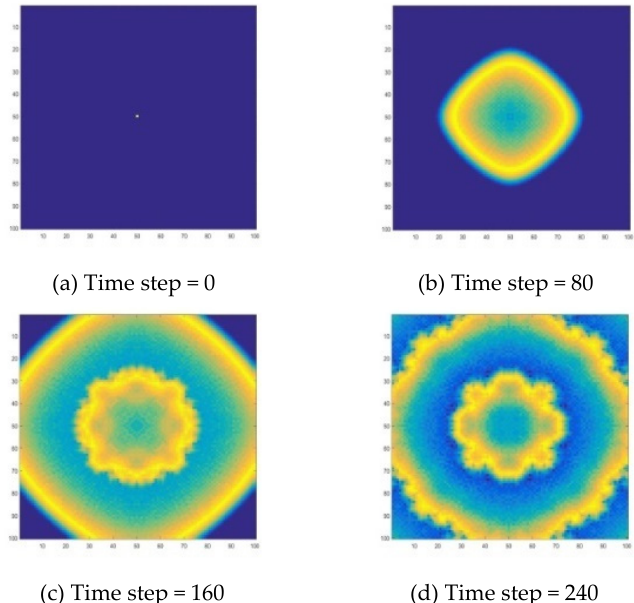
Figure 6. Simulated propagation of target wave for B-Z reaction by partial differential equation (PDE) model.